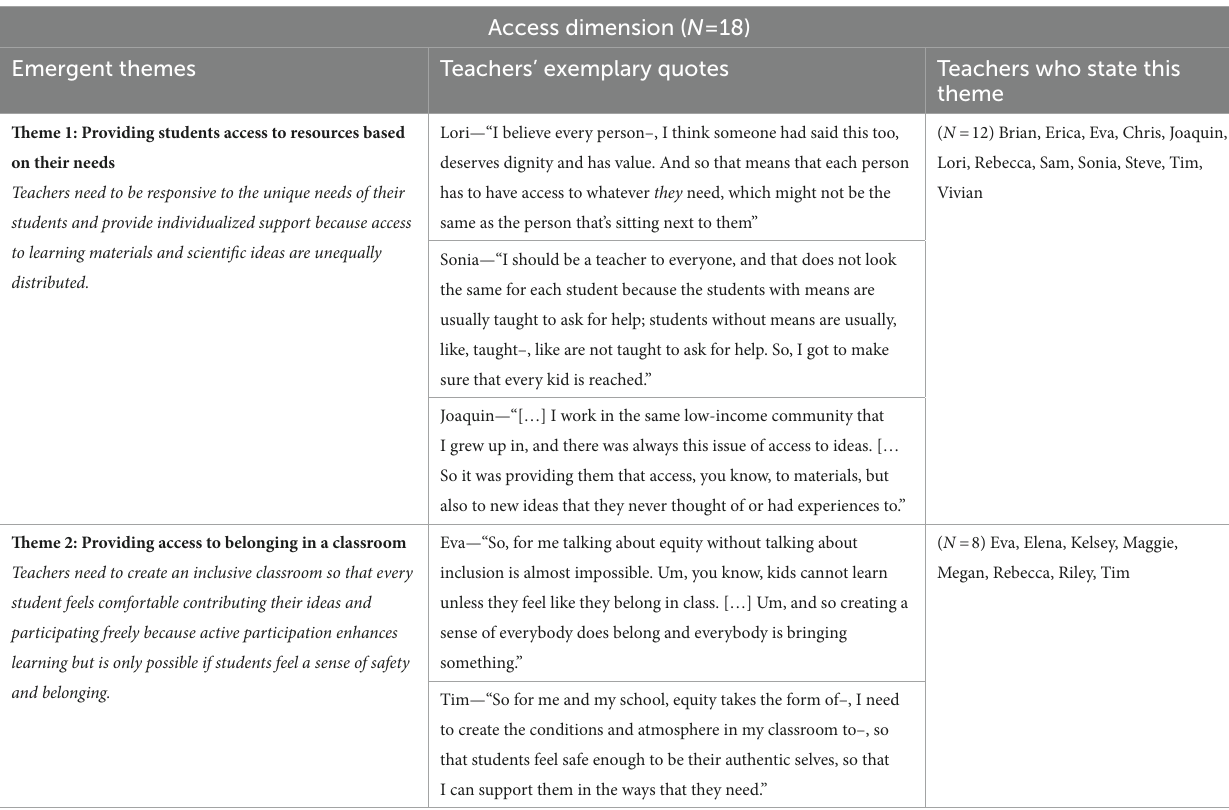
TABLE 2 Emergent themes of teachers’ conceptions of equity in access